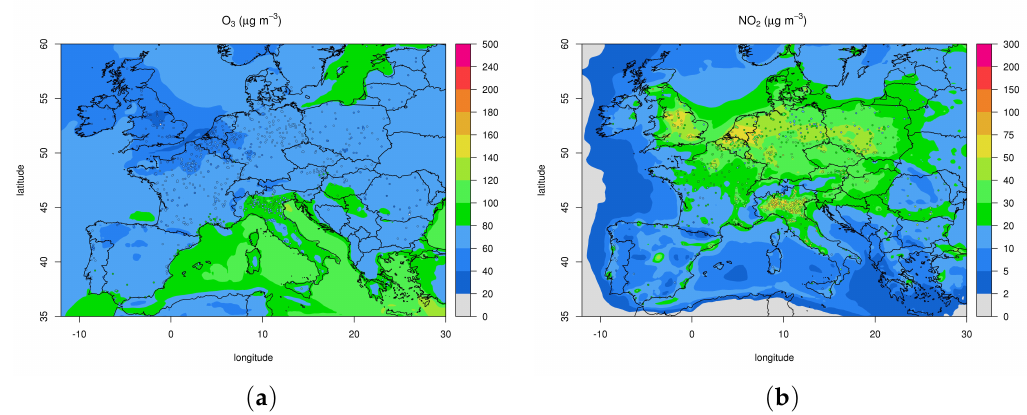
Figure 2. Seasonal average of model (maps) and measurements (filled circles) of O 3 concentration ( µ g m − 3 ) for June, July and August (JJA) season ( a ) and NO 2 concentration ( µ g m − 3 ) for December, January, February (DJF) season ( b